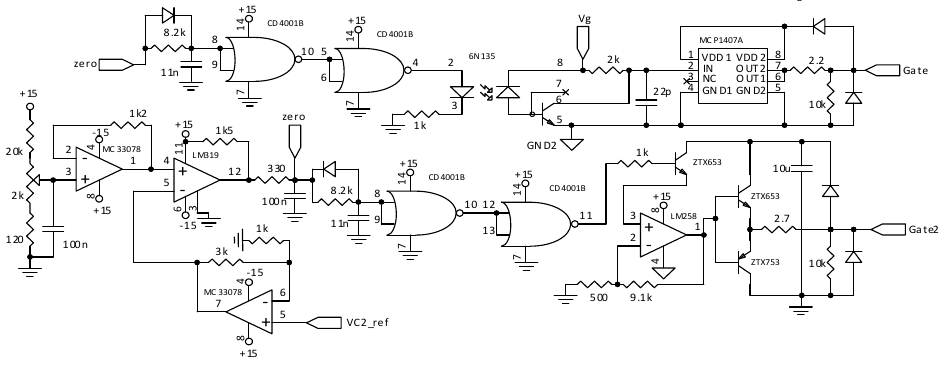
Figure 19. Power stage circuit and drivers of the unfolding/inverter stage.